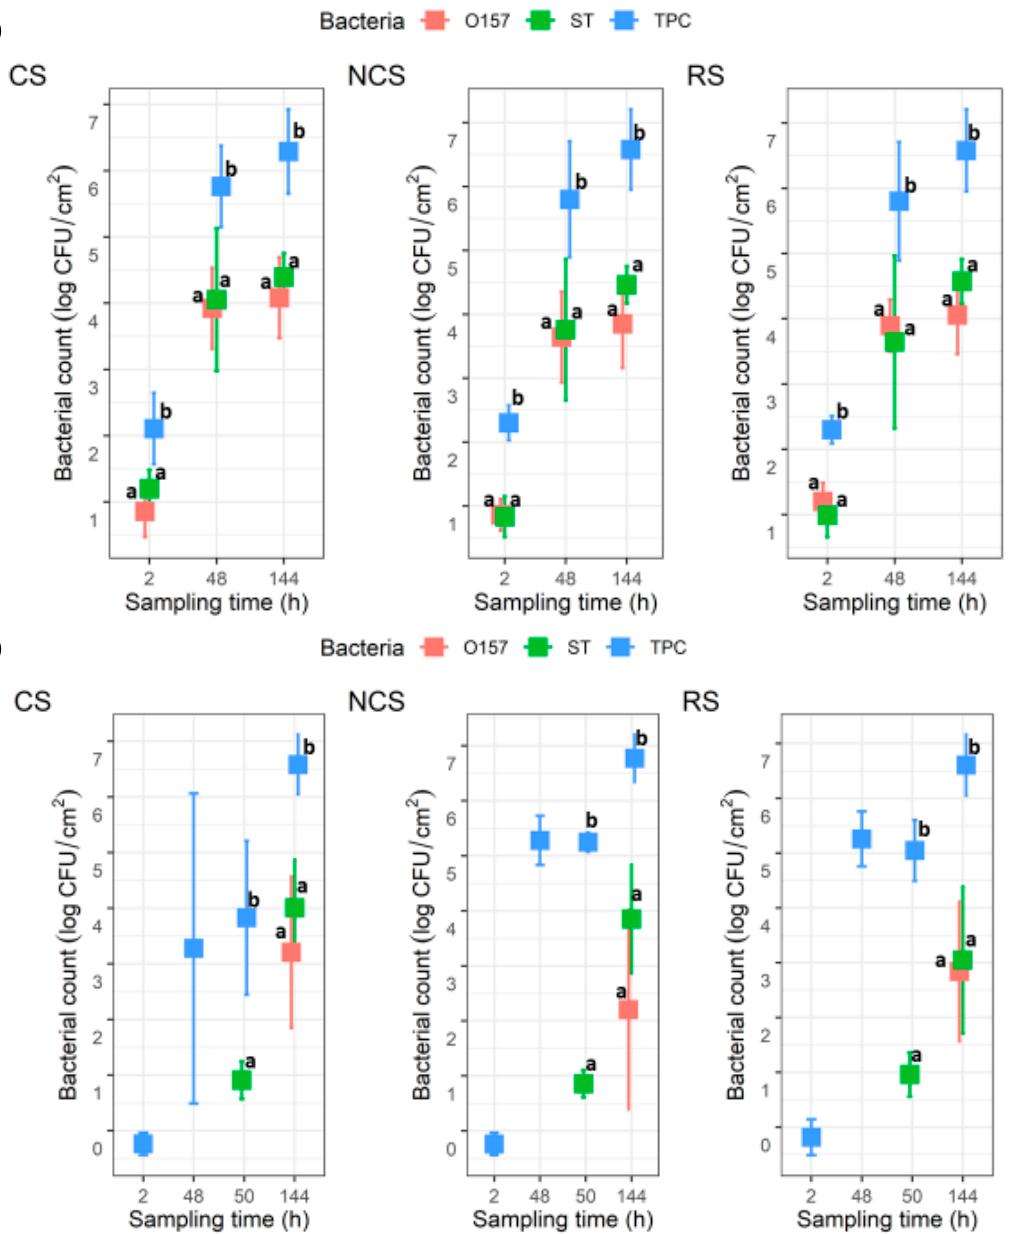
Figure 3. Total plate count (TPC), Escherichia coli O157:H7 (O157), and Salmonella Typhimurium (ST) counts in biofilms on stainless steel coupons (n = 6). The coupons were incubated at 15 ◦ C for six days in Lennox broth without salt inoculated with O157, ST, and meat processing surface bacteria (MPB). O157 and ST were introduced with MPB ( A ) or delayed by 48 h ( B ). MPBs were from the contact surfaces (CS), non-contact surfaces (NCS), and roller surfaces (RS) of the main conveyor belt on the fabrication floor of a beef processing facility. ANOVA was performed to compare the bacterial counts at each sampling time, followed by a Sidak post hoc pairwise comparison. Significant ( p < 0.05) differences are indicated by different lowercase